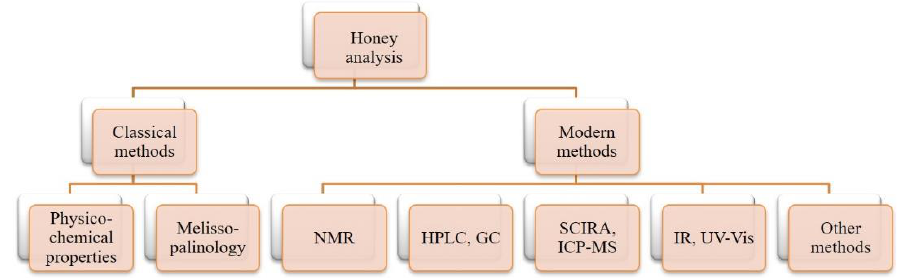
Figure 1. Different methods for honey analysis and authentication.